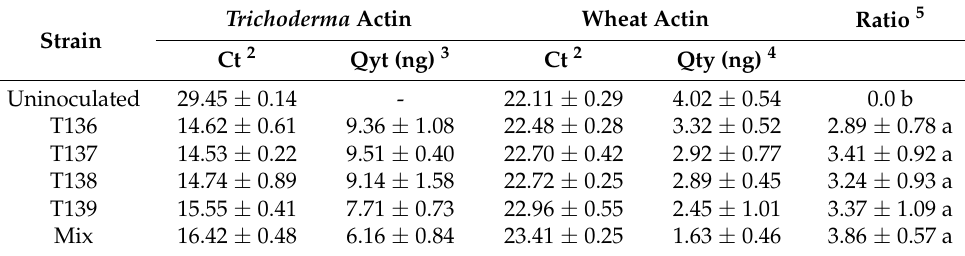
Table 4. Root colonization of wheat plants of the variety Basilio by four Trichoderma strains ( T. harzianum T136, T. simmonsii T137, T. afroharzianum T138, and T. harzianum T139) 1 .